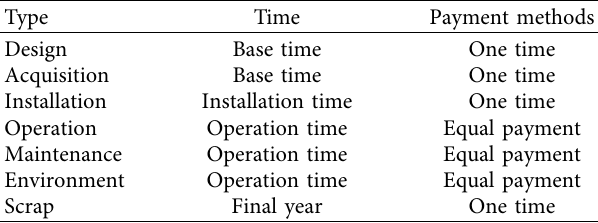
Table 2: Payment method and commutation time for each cost.